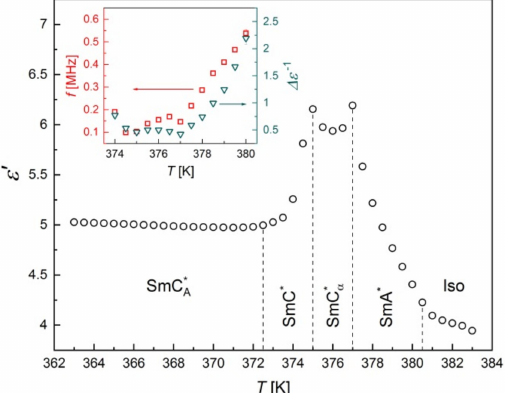
Figure 6. Dispersion part registered at 10 4 Hz upon cooling of the 3F7FPhH6 sample in a bias field of 40 V. The inset shows the frequency and inverse dielectric strength of the soft mode vs. temperature obtained by fitting Equation (1) to the spectra collected in the bias